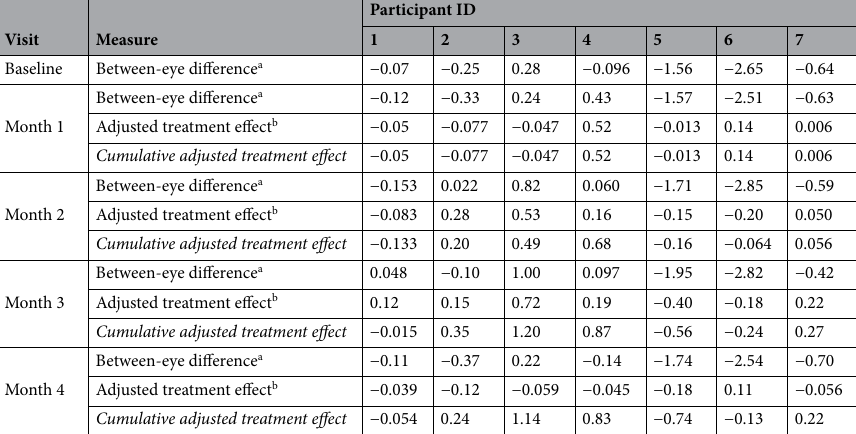
Table 2. Spherical equivalent refractive error at each study visit (using WAM; in diopters). a Calculated as treated eye minus control eye. Values greater than zeroindicate less myopic eyes. b Calculated as between-eye difference at visit minus the between-eye difference at baseline. Values greater than zero indicate a positive treatment effect (greater positive myopic shift in the treated eye as opposed to control